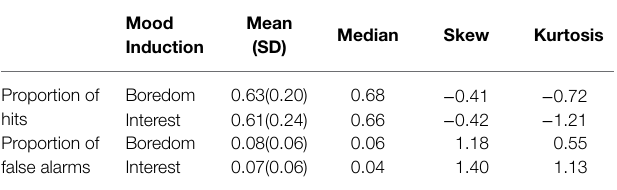
TABLE 1 | Proportions of hits and false alarms as a function of mood induction